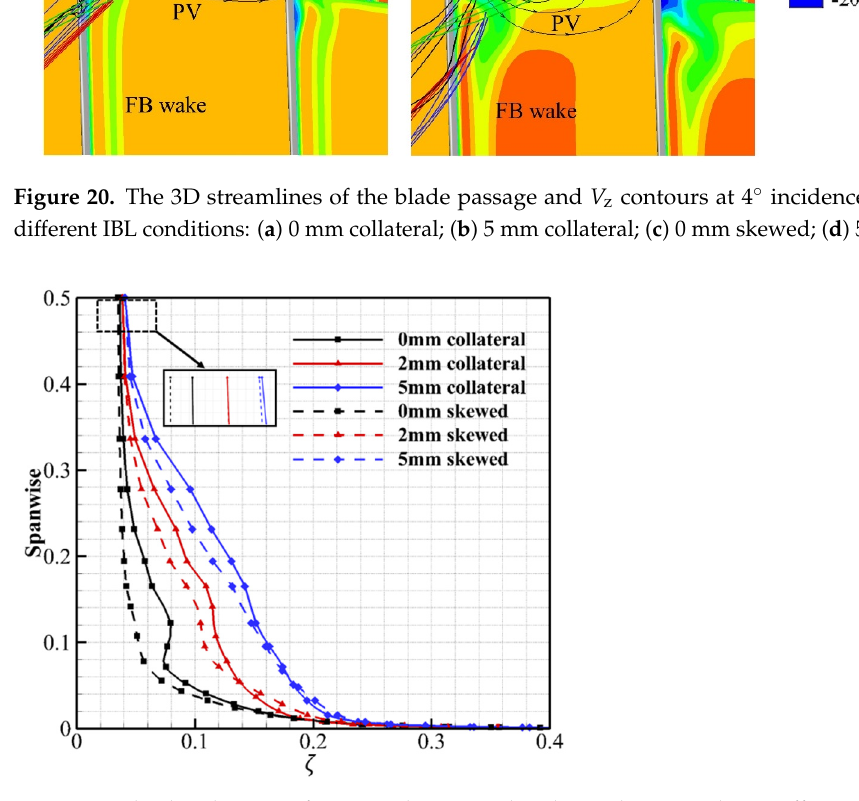
Figure 21. The distributions of mass pitch-averaged outlet total pressure loss coefficient of the tandem cascade along the spanwise.